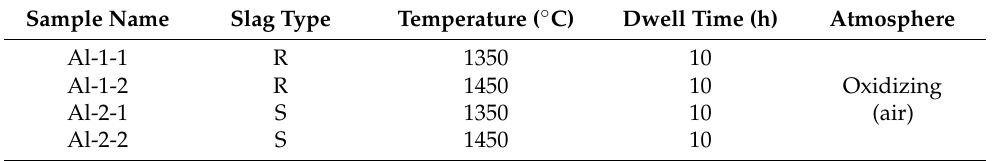
Table 3. Program of corrosion